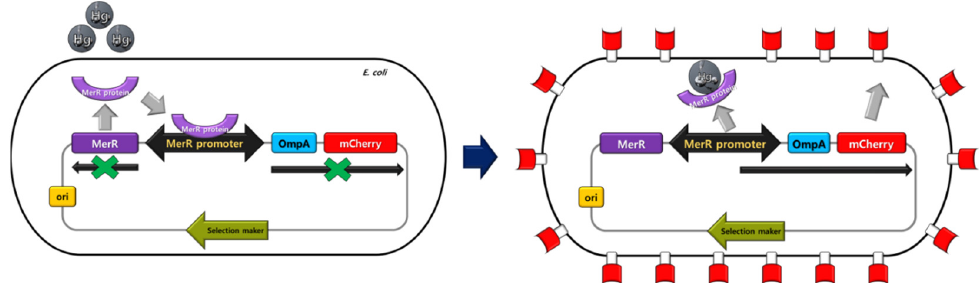
Figure 1. Action mechanism of the fluorescent metal-sensing strain (mercury